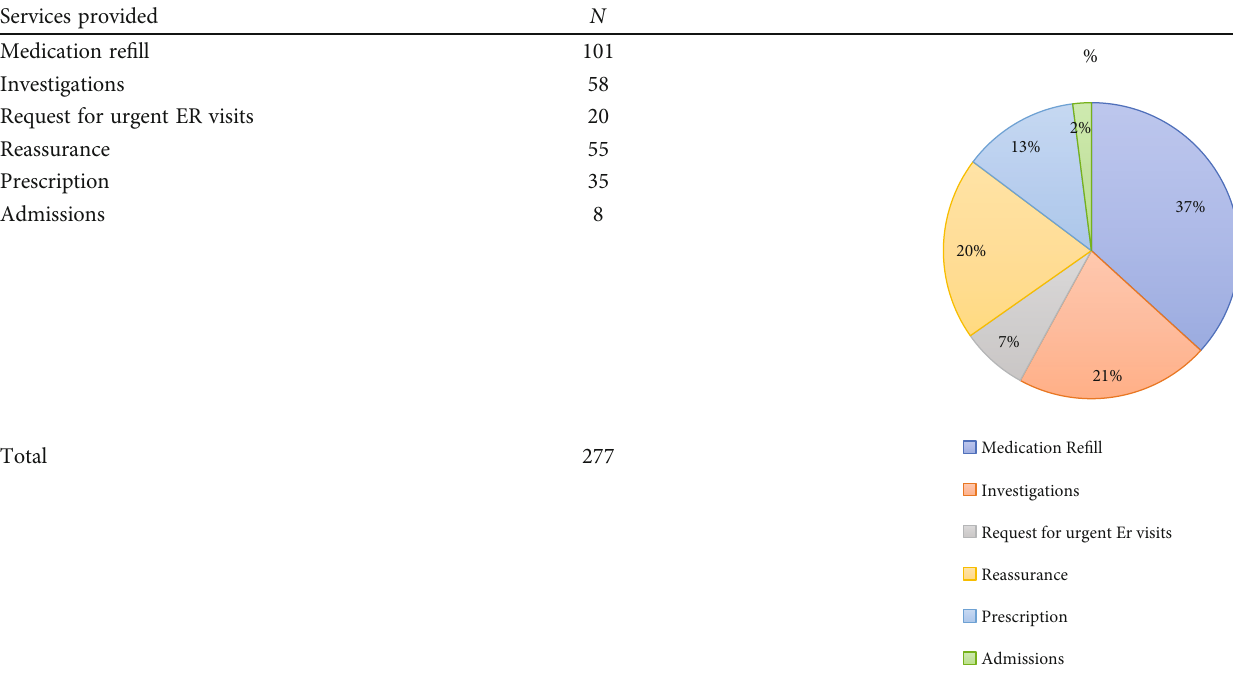
Table 3: Services provided to callers.